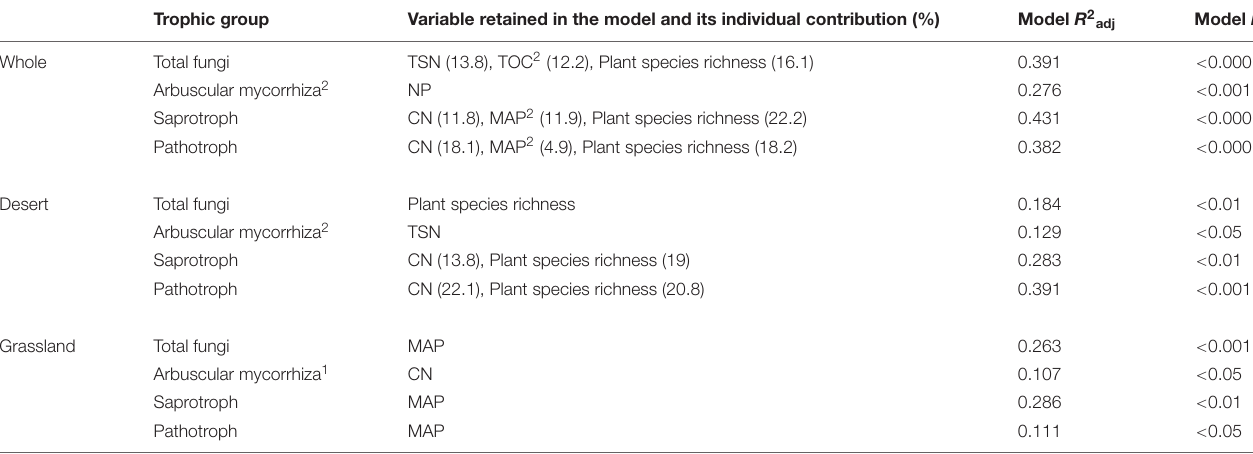
FIGURE 3 | Relationships between plant species richness and fungal richness (A–C) , and between plant community dissimilarity and fungal community dissimilarity (D–F) in the desert (A,D) , grassland (B,E) and whole region (C,F) . TABLE 2 | Stepwise multiple regressions of the species richness of different functional fungi with environmental variables in the desert, grassland and the whole region. Trophic group Variable retained in the model and its individual contribution (%) Model R 2 adj Model